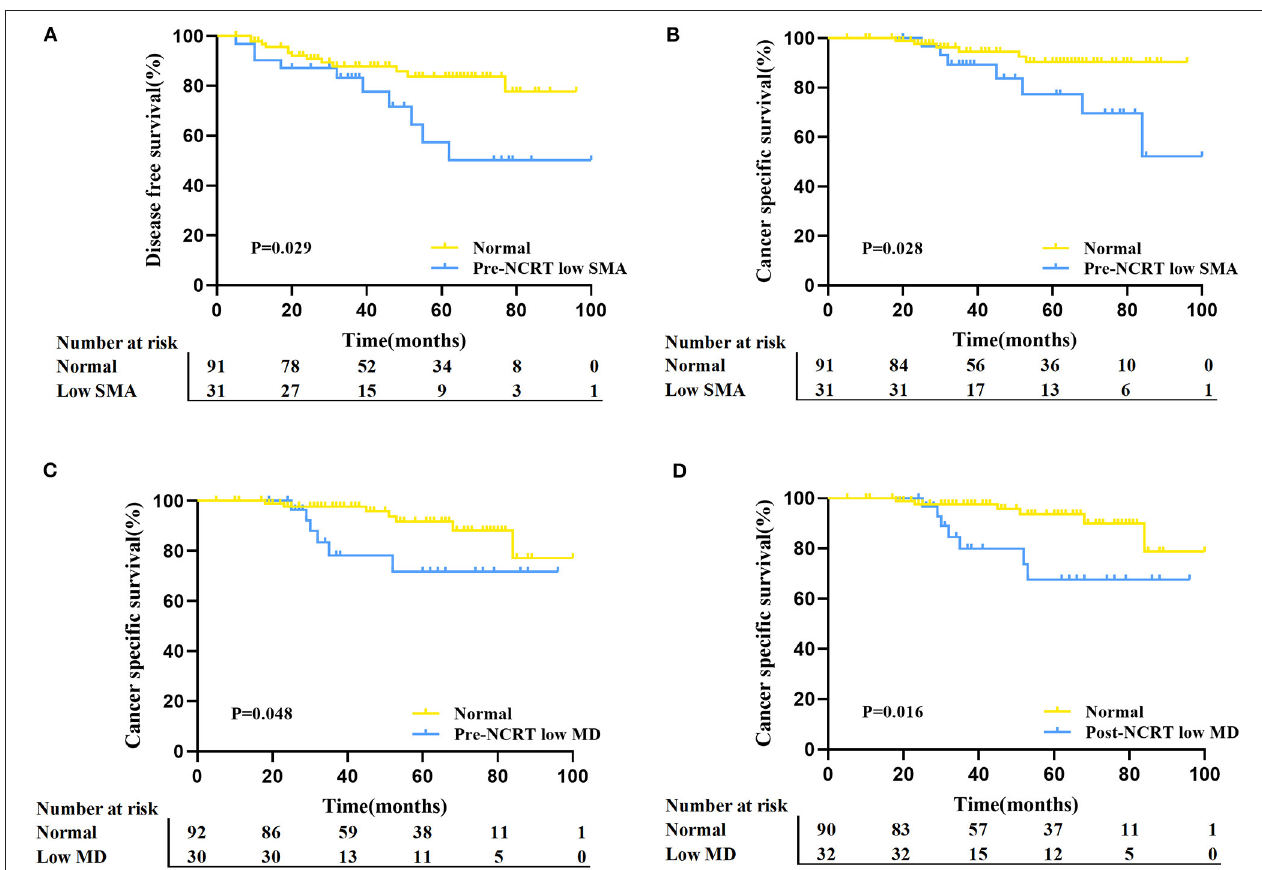
FIGURE 4 | Comparison of DFS and CSS between the different status of body composition in LARC patients. (A) Kaplan–Meier analysis for DFS rate between normal and pre-NCRT low SMA groups in LARC patients ( p = 0.029). (B) Kaplan–Meier analysis for the CSS rate between normal and pre-NCRT low SMA groups in LARC patients ( p = 0.028). (C) Kaplan–Meier analysis for CSS rate between normal and pre-NCRT low MD groups in LARC patients ( p = 0.048). (D) Kaplan–Meier analysis for the CSS rate between normal and post-NCRT low MD in LARC patients ( p =